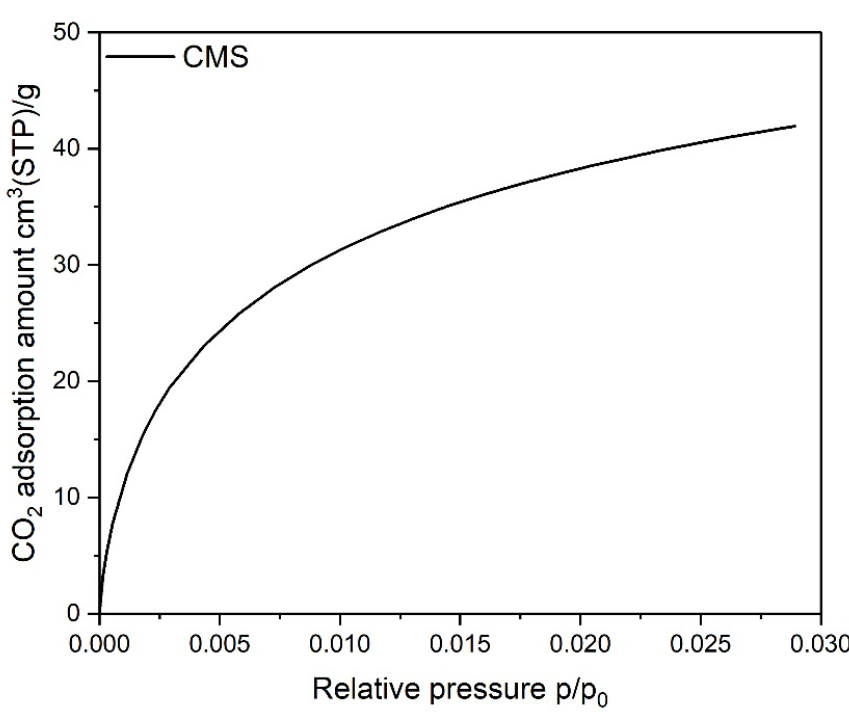
Figure 2. Isotherms of CO 2 adsorption on the CMS sample. The measured adsorption isotherms of N 2 and CO 2 are presented in Figures 1 and 2, respectively. The AC material shows a type I isotherm with a narrow knee at low relative pressure, meaning that mainly micropores are present in this material. The RPC material is exhibited as an isotherm of type II, which is characteristic of low porous